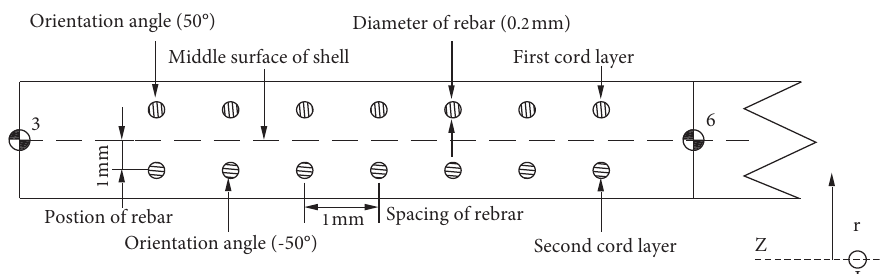
Figure 7: The cord rebar model of the